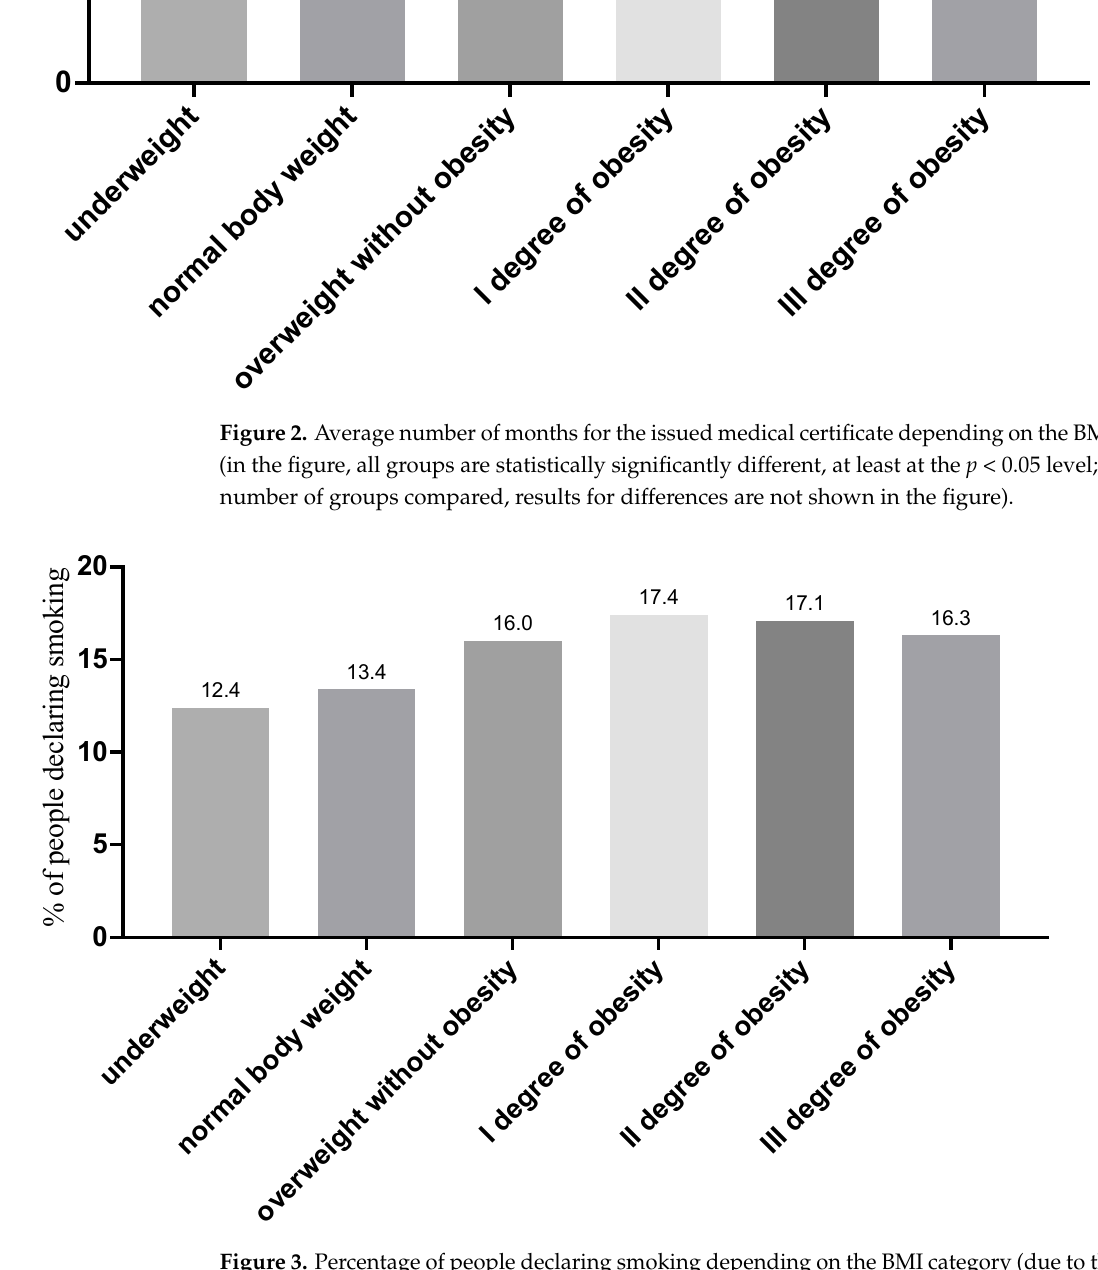
Figure 3. Percentage of people declaring smoking depending on the BMI category (due to the number of groups compared, results for differences are not shown in the figure). The relationship between BMI categories and subjective health assessment was also examined. It was found that people who subjectively assessed their own health as good, less often than people who assessed their health as very good, were classified into the